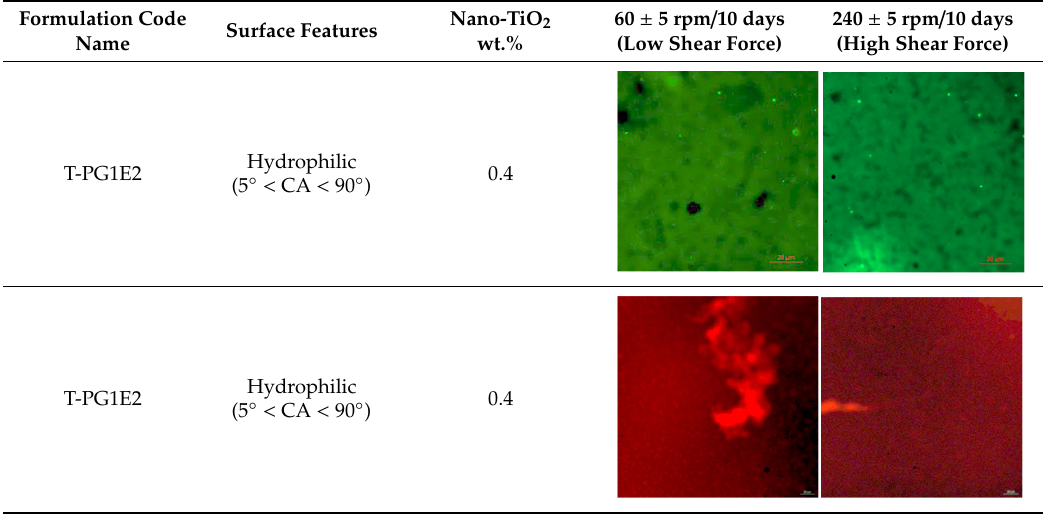
Table 4. Live/dead microscopy of control group indicating the effect from nano-TiO 2 wt.%.